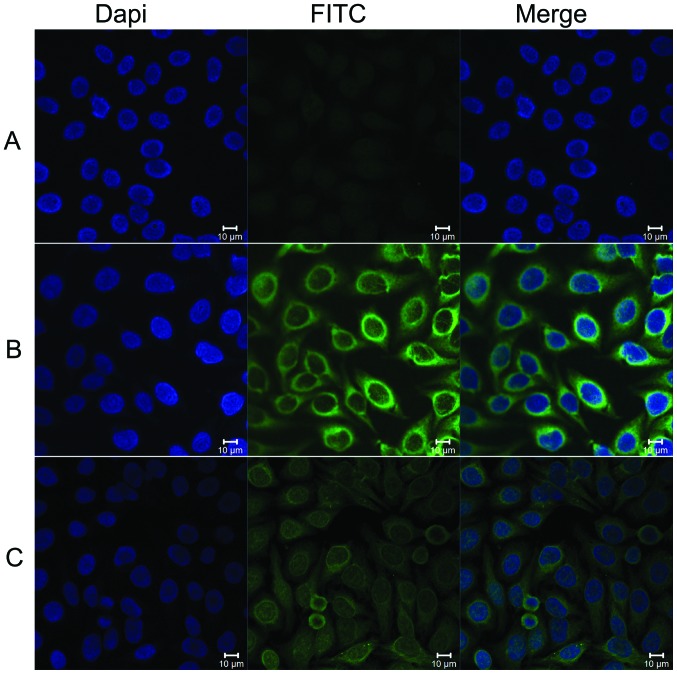
Representative immunofluorescence staining pattern of anti-Prdx1 antibody-positive ESCC serum. (A) A normal human serum sample used as a negative control. (B) A representative anti-Prdx1 antibody-positive ESCC serum sample demonstrating a perinuclear immunofluorescence staining pattern.(C) The same ESCC serum sample in B was pre-absorbed with recombinant Prdx1 protein, and subsequently utilized for immunofluorescence assay. The fluorescent signal was intensely reduced. Prdx1, peroxiredoxin 1; ESCC, esophageal squamous cell carcinoma.